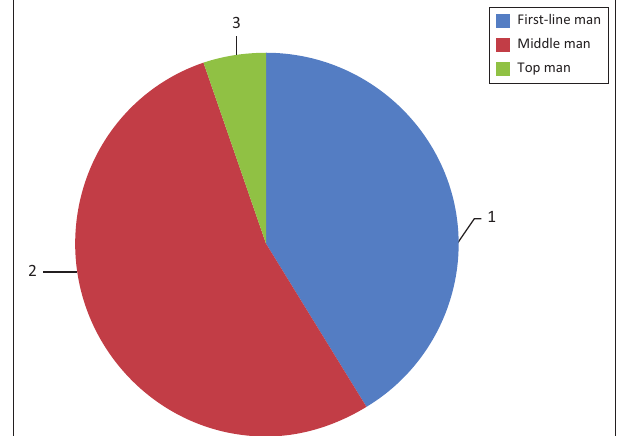
FIGURE 2: Position within the company.